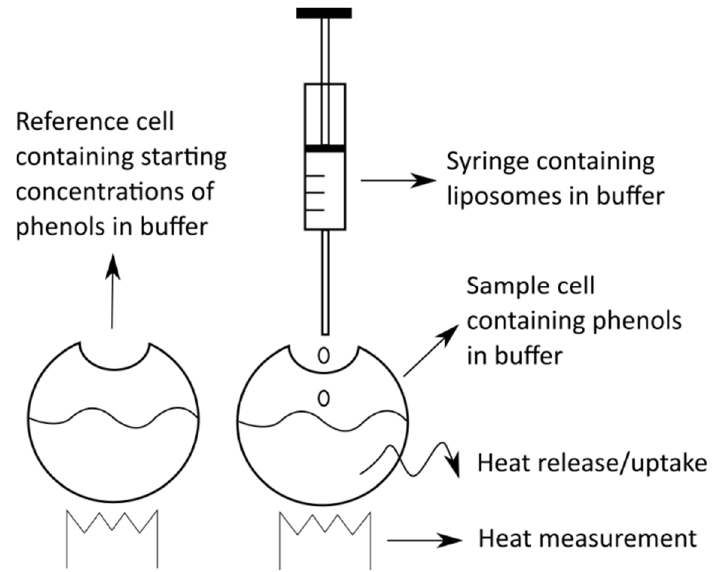
Figure 5. The principles and practice of isothermal titration calorimetry.